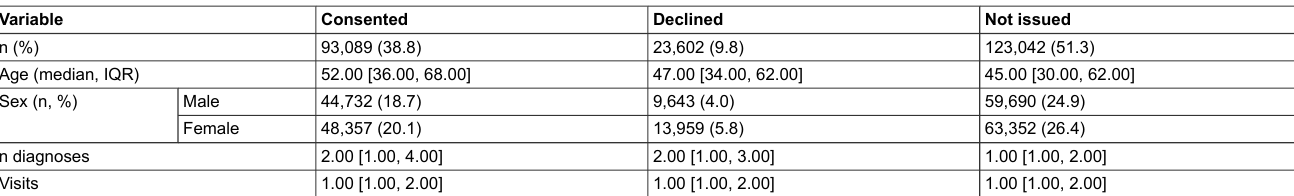
Table 4: Baseline characteristics for General Consent status groups consented, declined, and not issued (total n = 239,733). Variable